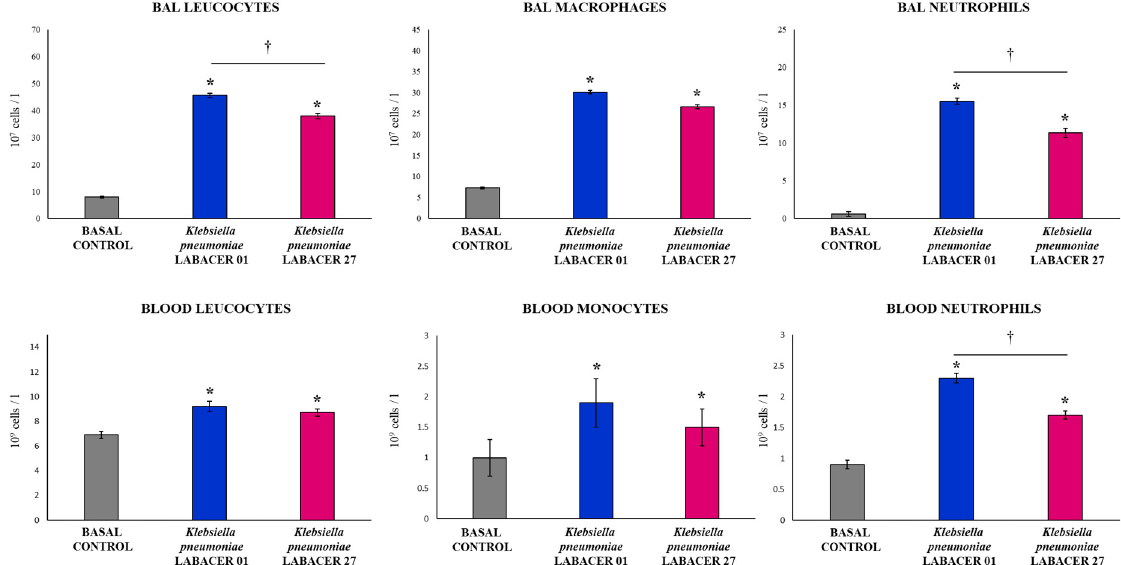
Figure 2. Variations in respiratory and blood leukocytes induced by KPC-2-producing hypermucoviscous ST25 strains of Klebsiella pneumoniae . Immunocompetent adult BALB/c mice (six weeks) were nasally challenged with K. pneumoniae LABACER 01 or LABACER 27. Two days after challenge, leukocyte, macrophage, and neutrophil counts were performed in broncho-alveolar lavage (BAL) samples, and leukocyte, monocyte, and neutrophil counts were performed in blood. Results represent data from three independent experiments. Asterisks (*) indicate significant differences from the uninfected control group (basal control), p < 0.05. The crosses (†) indicate significant differences between the indicated groups, p < 0.05.